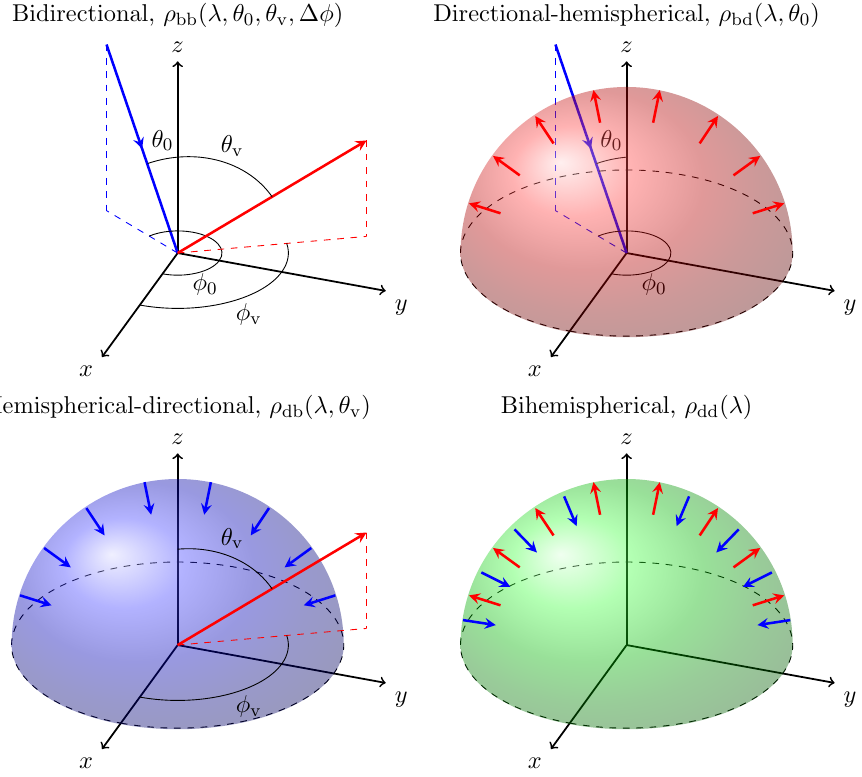
Figure 2. Schematic diagrams of each of the four ORAC surface reflectance operators. Blue represents incident radiation and red represents reflected radiation. The long arrows represent beam transport and the hemispheres with short arrows represent diffuse